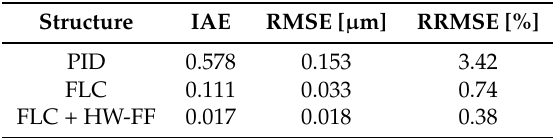
Table 2. Results obtained of the integral of the absolute error (IAE), root-mean-square error (RMSE) and relative root-mean-square-error